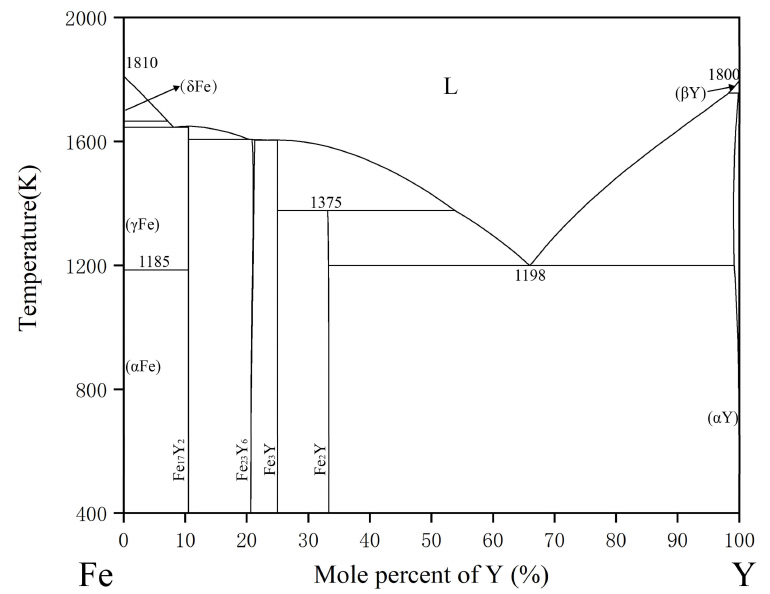
Figure 2. The calculated Fe-Y phase diagram based on the work of Saenko et al.